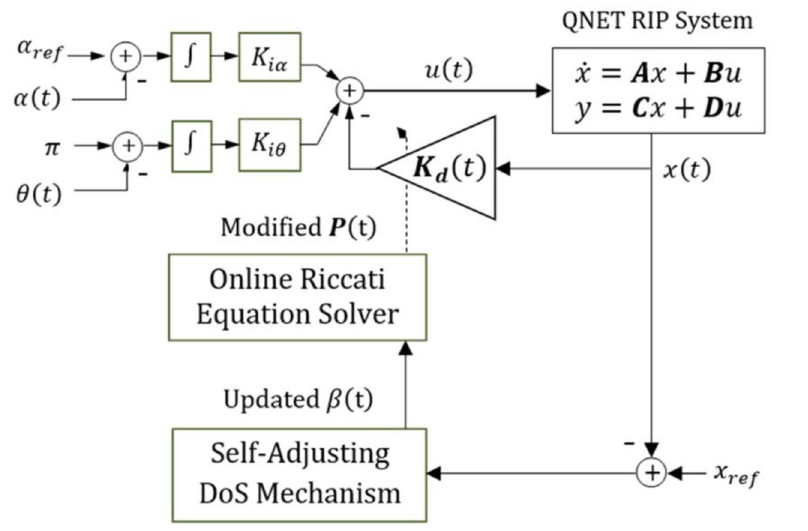
Fig 2. The block diagram of the